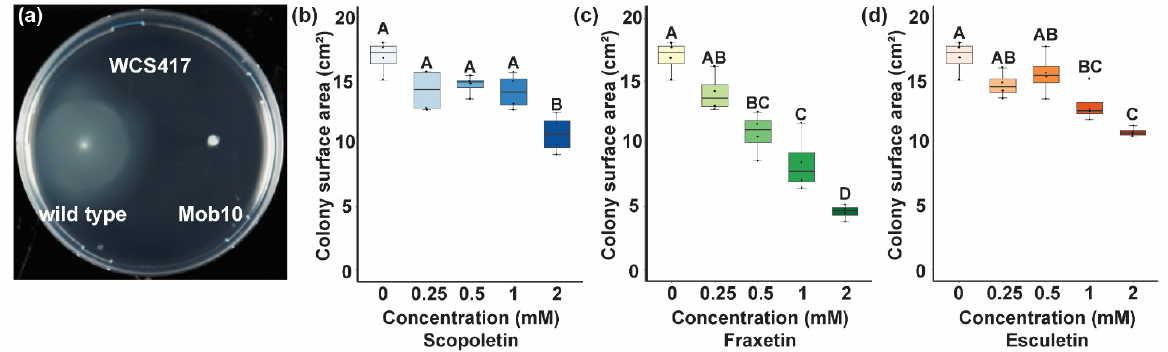
Figure 4. Effect of tested coumarins on bacterial flagellar motility. ( a ) Representative photo of colonies of wild-type WCS417 and Mob10, a WCS417 Tn5-mutant lacking flagella, growing on the semi-solidified medium after 70 h. ( b – d ) Effect of increasing concentrations of ( b ) scopoletin, ( c ) fraxetin, and ( d ) esculetin on the colony surface area of wild-type WCS417. Boxplots represent four replicate colonies per concentration. Capitals indicate statistically significant ( p < 0.05) differences as determined via ANOVA followed by Tukey’s post-hoc test. Table 1. Expression and annotation data of 22 DEGs in the COG cell motility category. + signifies that the gene positively affects the root colonization capability of WCS417 (Cole et al., 2017). In log2-fold change, positive values mean that the genes are up-regulated by F6 (cid:48) H1-dependent root exudates, whereas negative values mean that the genes are down-regulated by F6 (cid:48) H1-dependent root